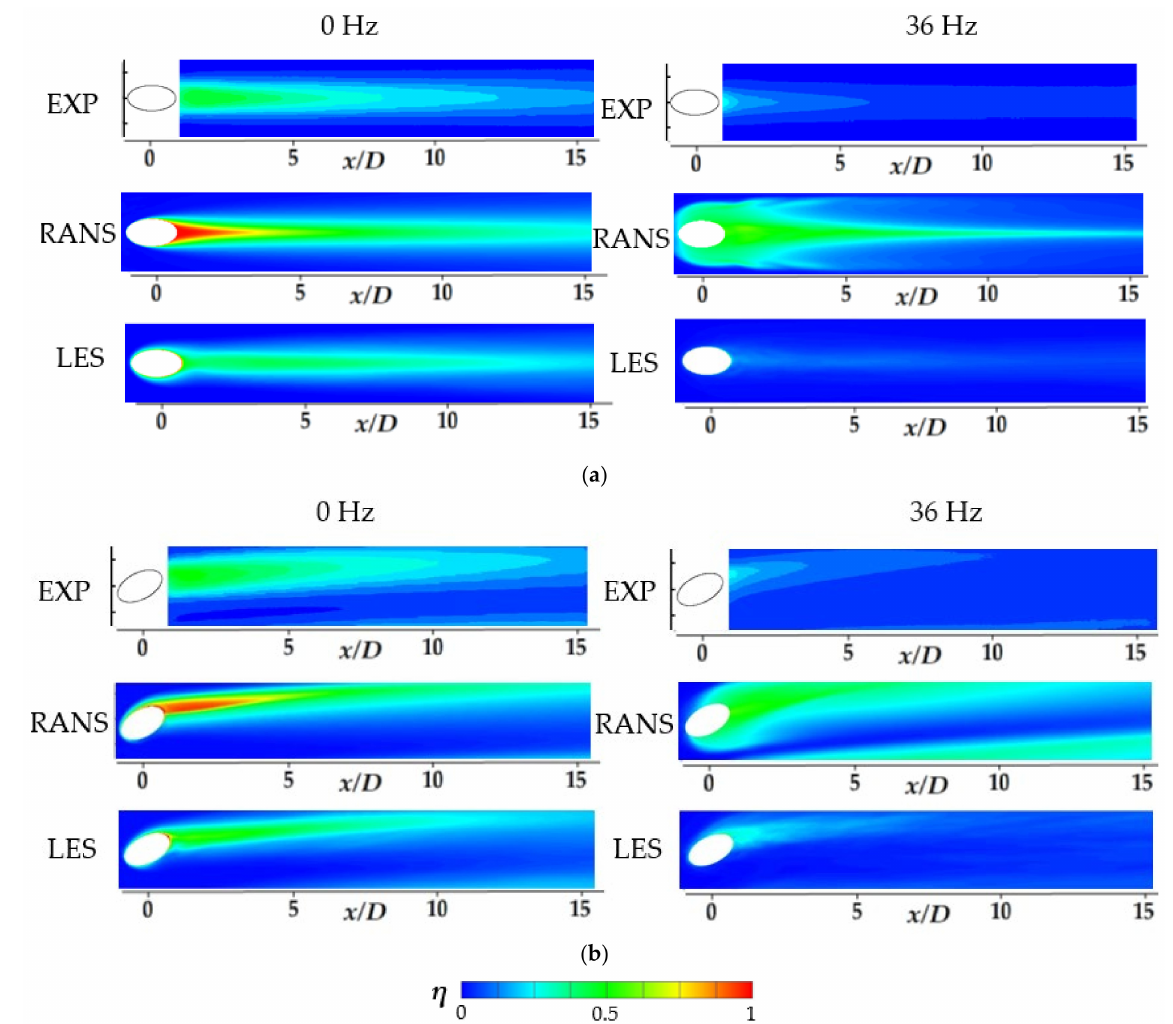
Figure 7. Contours of time-averaged film cooling effectiveness on the wall at steady state and 36 Hz pulsation. ( a ) Simple angle ( β = 0 ◦ ); ( b ) Compound